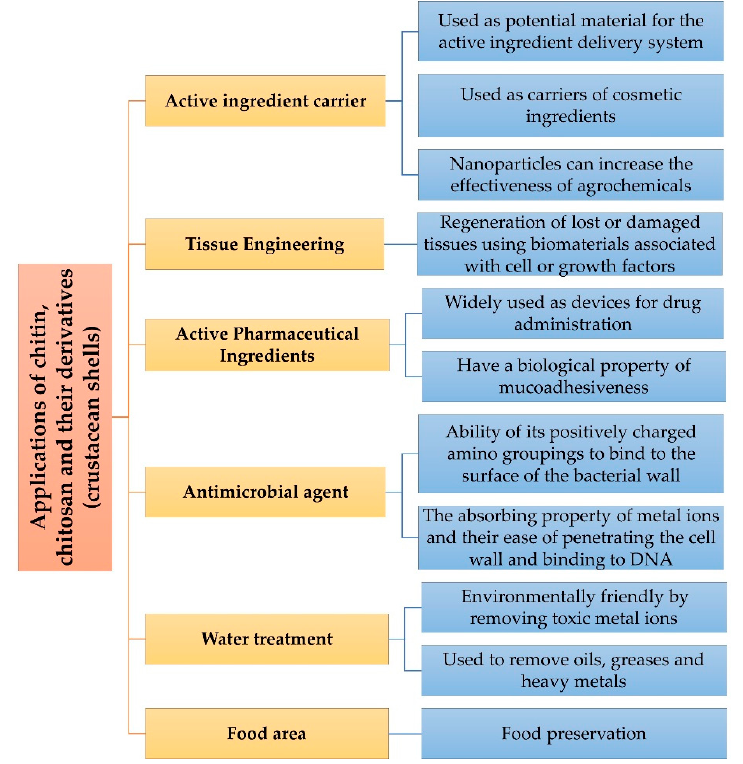
Figure 6. Flowchart of the summary of the main applications of chitin/chitosan.